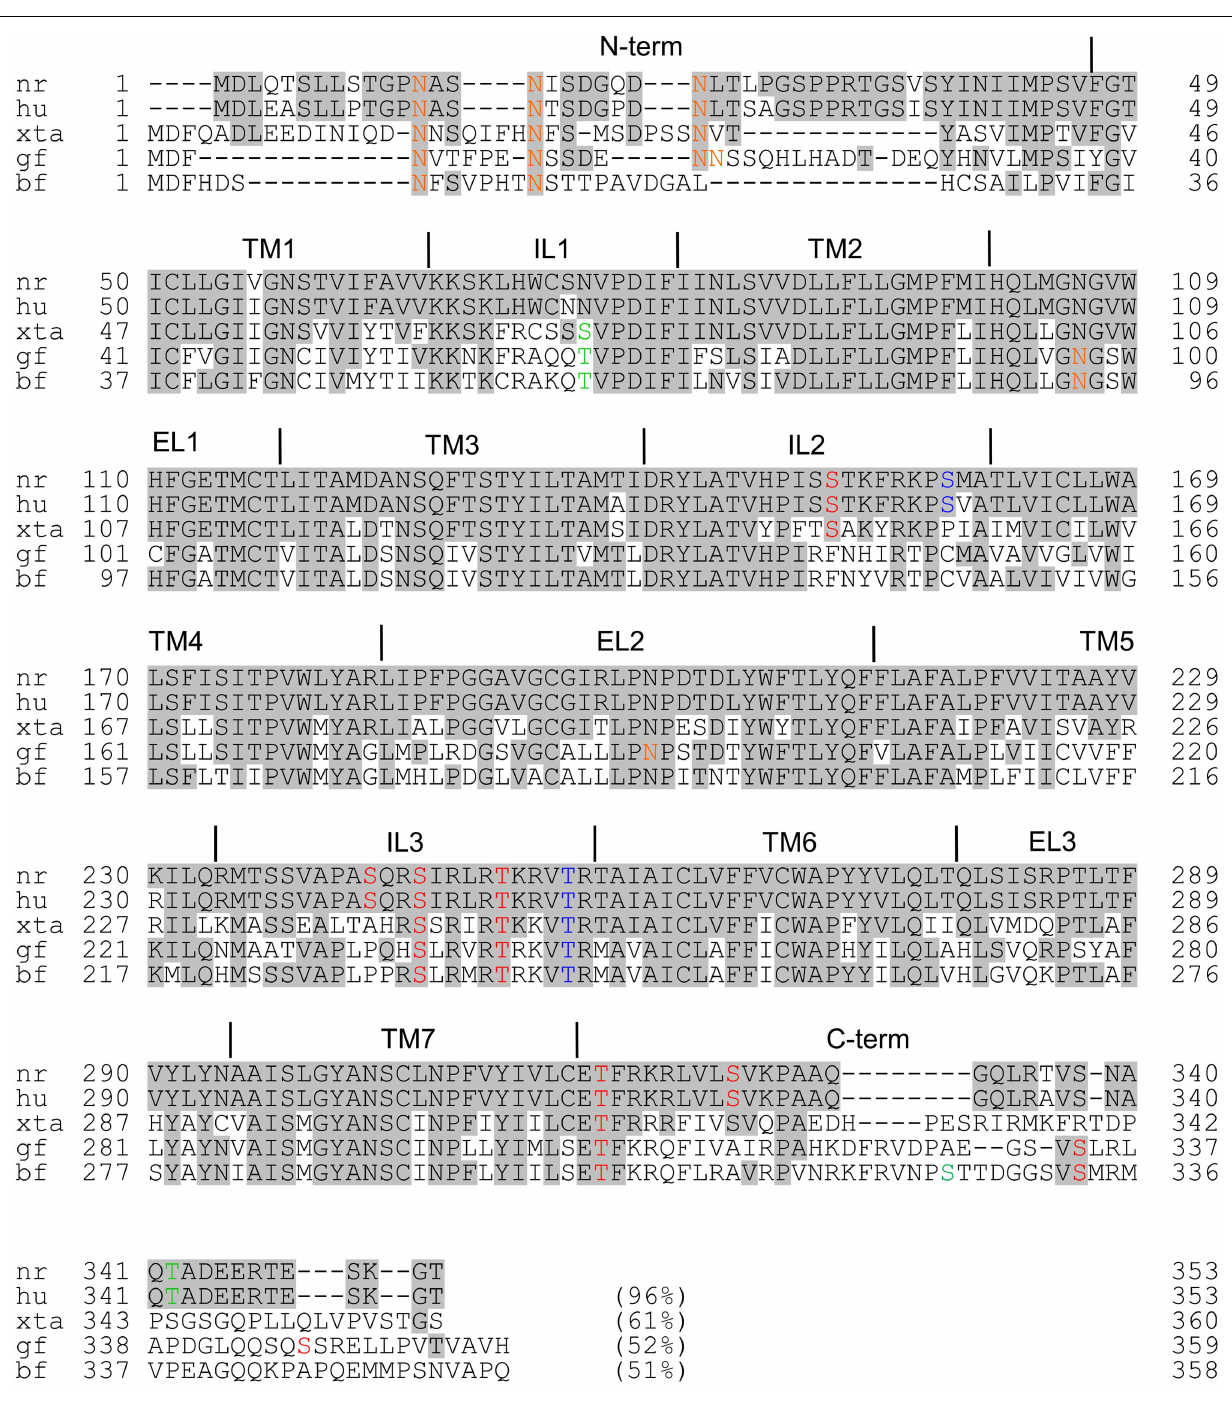
FIGURE 1 |Amino acid comparisons of Norway rat MCHR1 and its mammalian, amphibian, and fish orthologs .The accession numbers are as follows: Norway rat (nr), NP_113946; human (hu), NP_005288; Xenopus tropicalis 1a (xta), NP_001072243; goldfish (gf), BAH70338; barfin flounder (bf), BAF49517. Common amino acids with rat MCHR1 are shaded. Colored